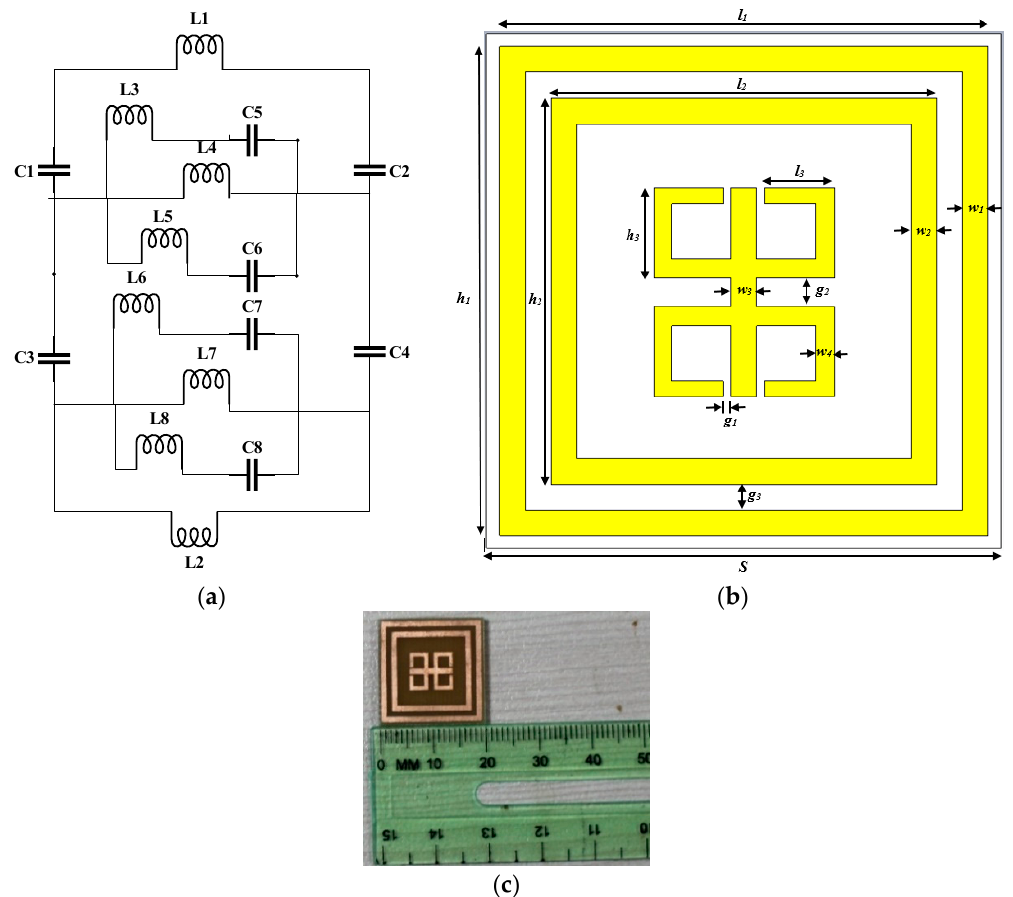
Figure 1. Proposed metamaterial absorber design ( a ) Equivalent circuit of prototype ( b ) unit cell absorber with dimension, and ( c ) fabricated prototype.